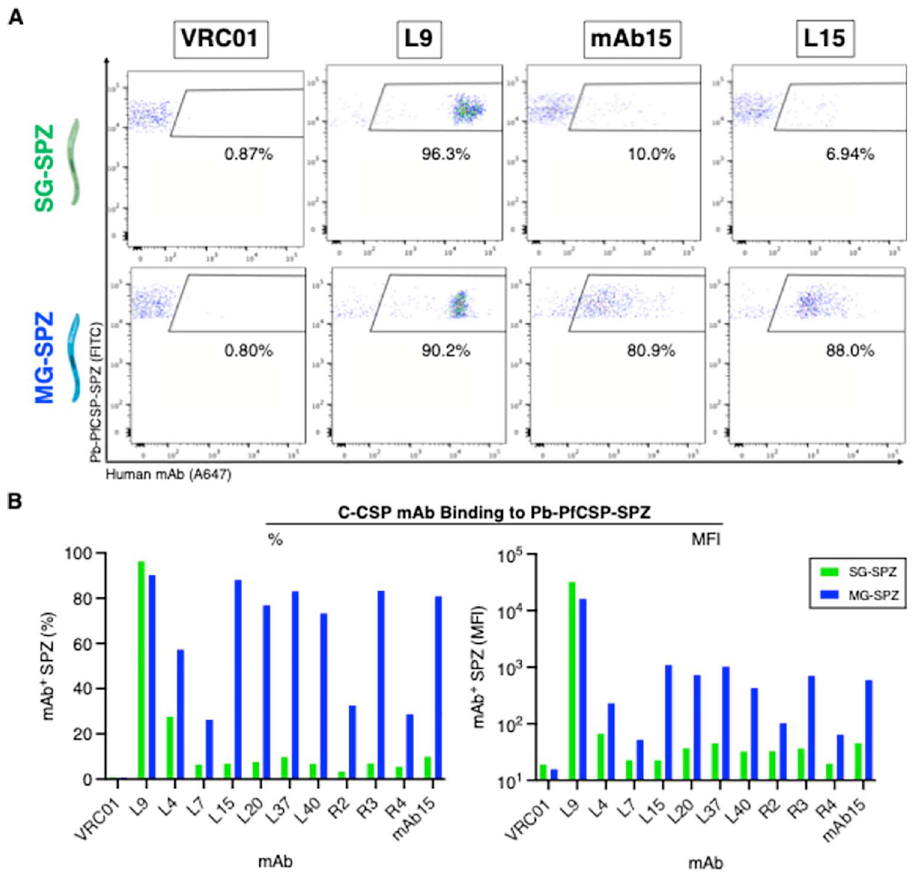
Fig 3. C-CSP mAbs differentiate between PfCSP conformations on Pb-PfCSP-SPZ. (A) Representative flow cytometry plots depicting 20 μ g/mL of indicated mAb binding to Pb-PfCSP-SPZ harvested from the salivary glands (SG-SPZ, green) or midguts (MG-SPZ, blue) of mosquitos. (B) Percentage and MFI of SG vs. MG Pb-PfCSP-SPZ bound by 20 μ g/mL of indicated mAb, measured by flow cytometry. VRC01 and L9 (NVDP-specific repeat mAb) were included as negative and positive